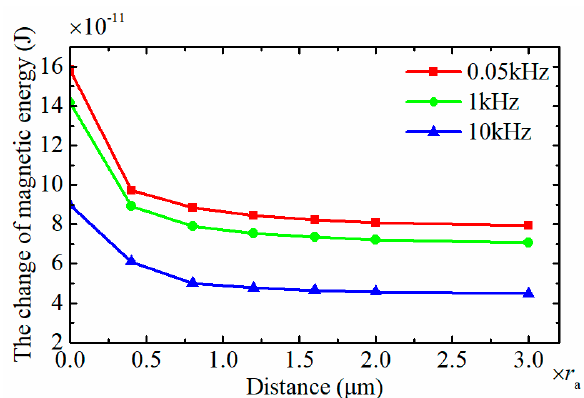
Figure 10. The change of the magnetic energy resulted from the dual wear particles system.